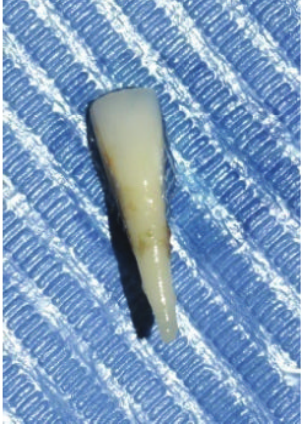
Figure 3: Extracted tooth.